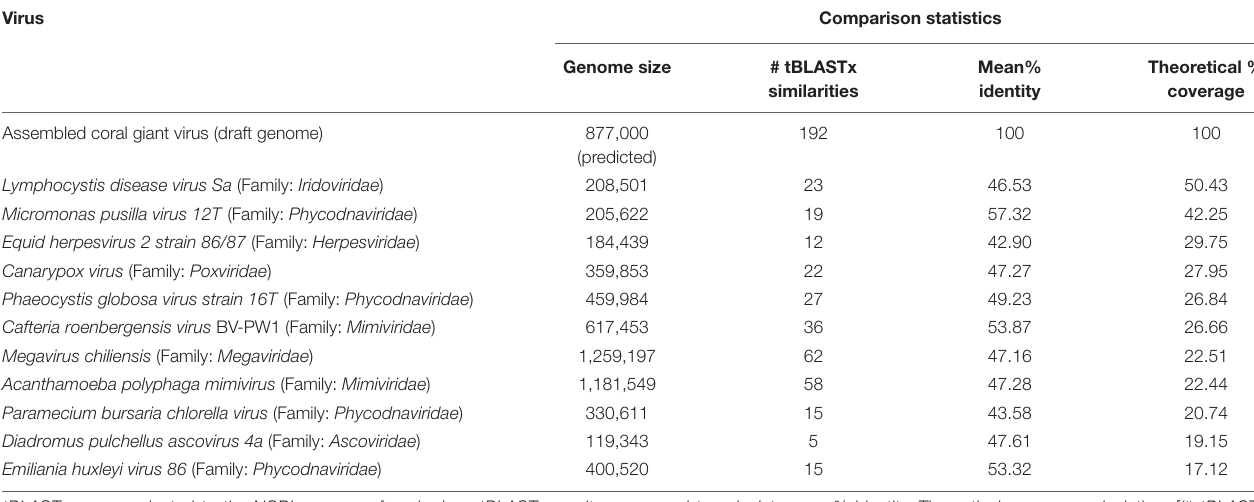
TABLE 3 | Comparison of assembled coral virus draft genome with other known dsDNA viruses. Virus